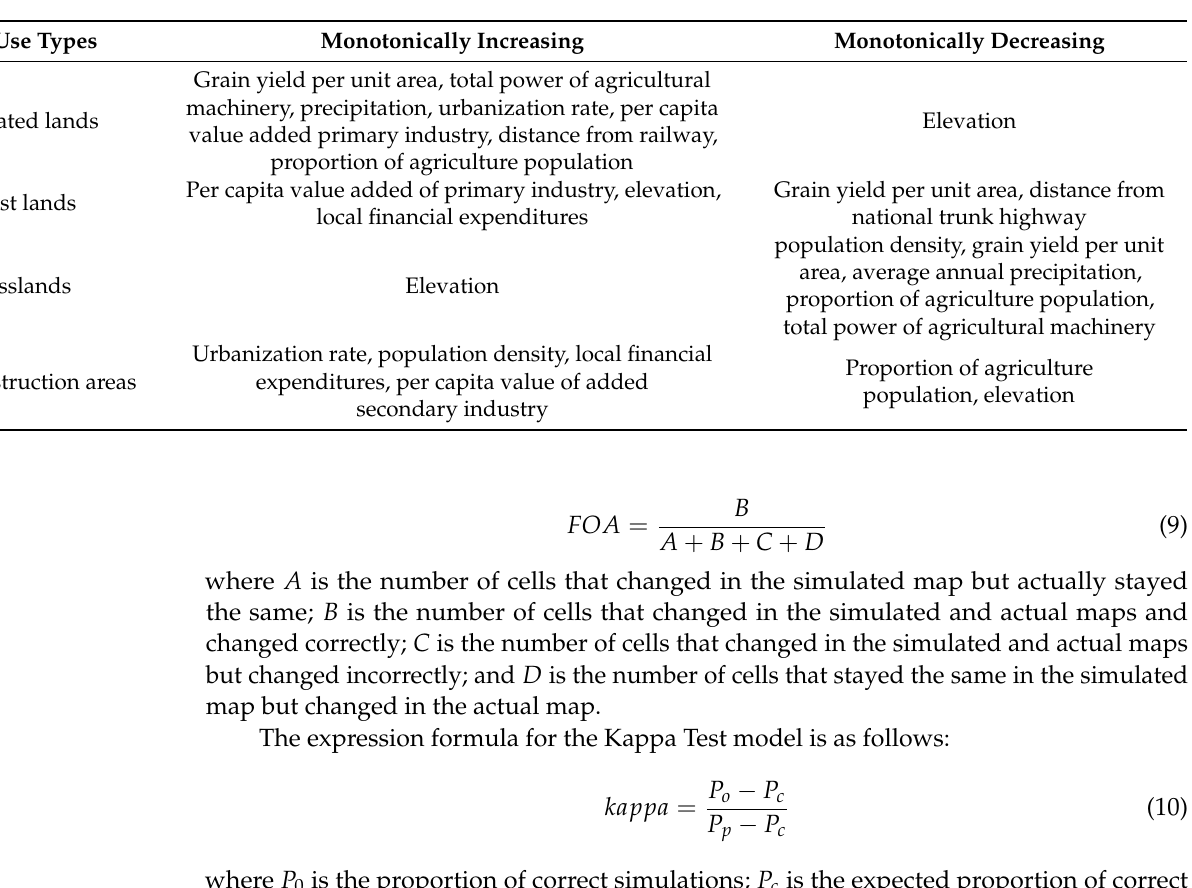
Table 3. NG scenario parameter setting (J-shape curve).